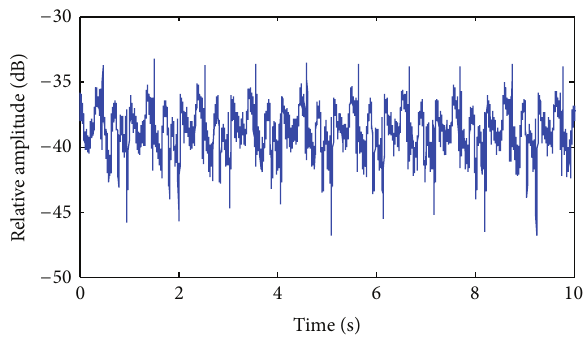
Figure 1: Example of the periodic time variability of the scattering signals as blades